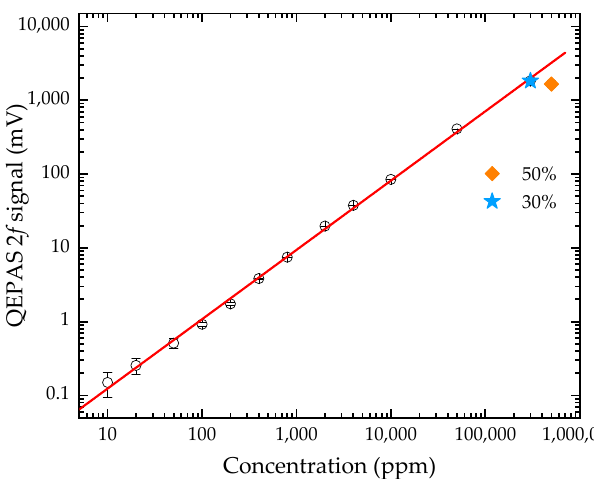
Figure 6. Linearity of the QEPAS 2 f signal as a function of CO 2 concentration at 1 bar and 296 ± 2 K. The linear fitting yields an R-square value of 0.9985 from 10 ppm to 30%.